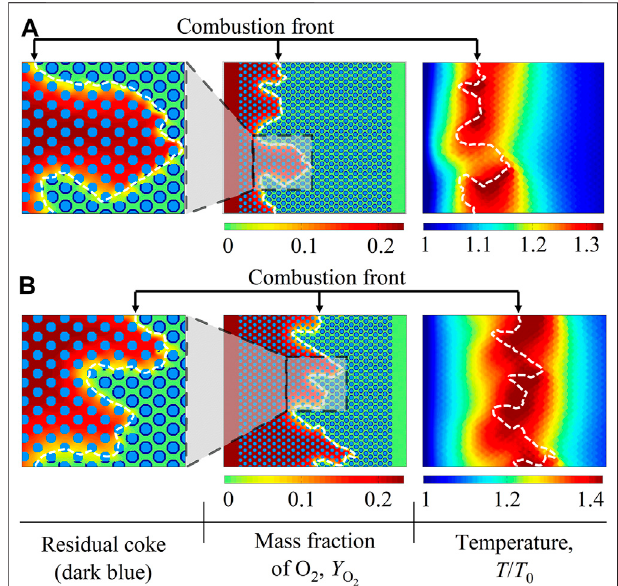
FIGURE 10 | Contours of residual coke, the O 2 mass fraction Y O temperature T / T 0 for the twocases at t (cid:2) 8.14 swith (A) R y (cid:2) 4, R t (cid:2) 0 and (B) R y (cid:2) 4, R t (cid:2) −